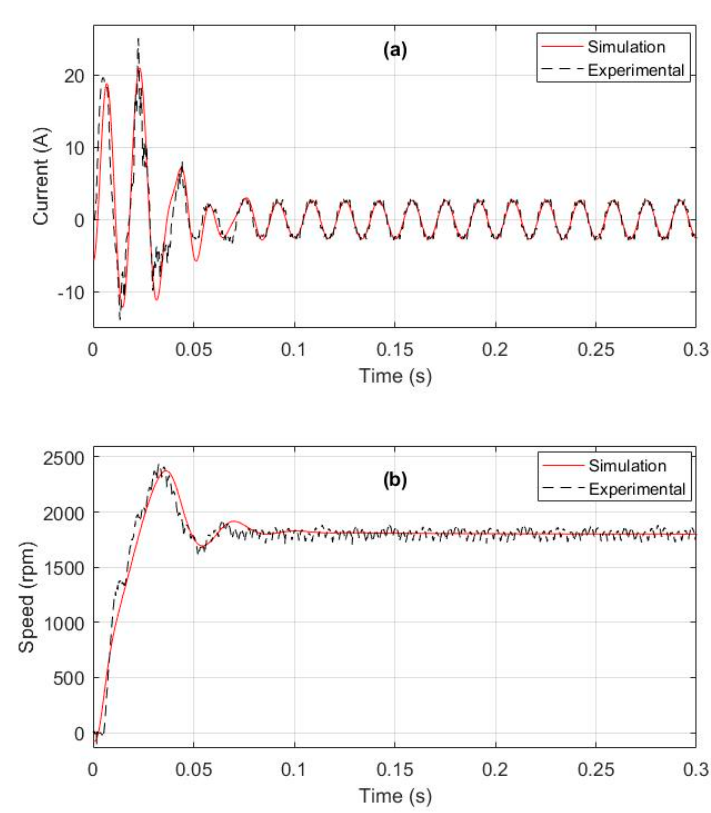
Machines 2019 , 7 , x FOR PEER REVIEW Figure 19. LSPMSM under no-load ( a ) Stator phase A Current ( b ) speed. Figure 19. LSPMSM under no-load ( a ) Stator phase A Current ( b ) speed.